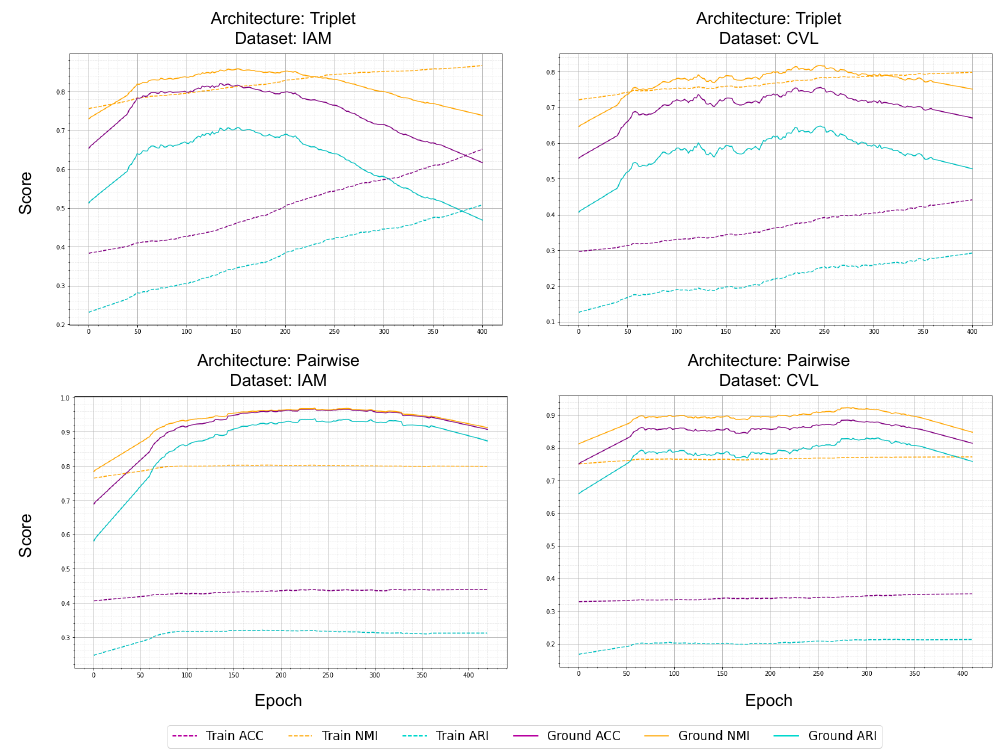
Figure 6. Graphs illustrating the metrics of the training and ground dataset containing 25 writers with an impurity of 0. The first row represents the triplet network and the second row represents the pairwise network,